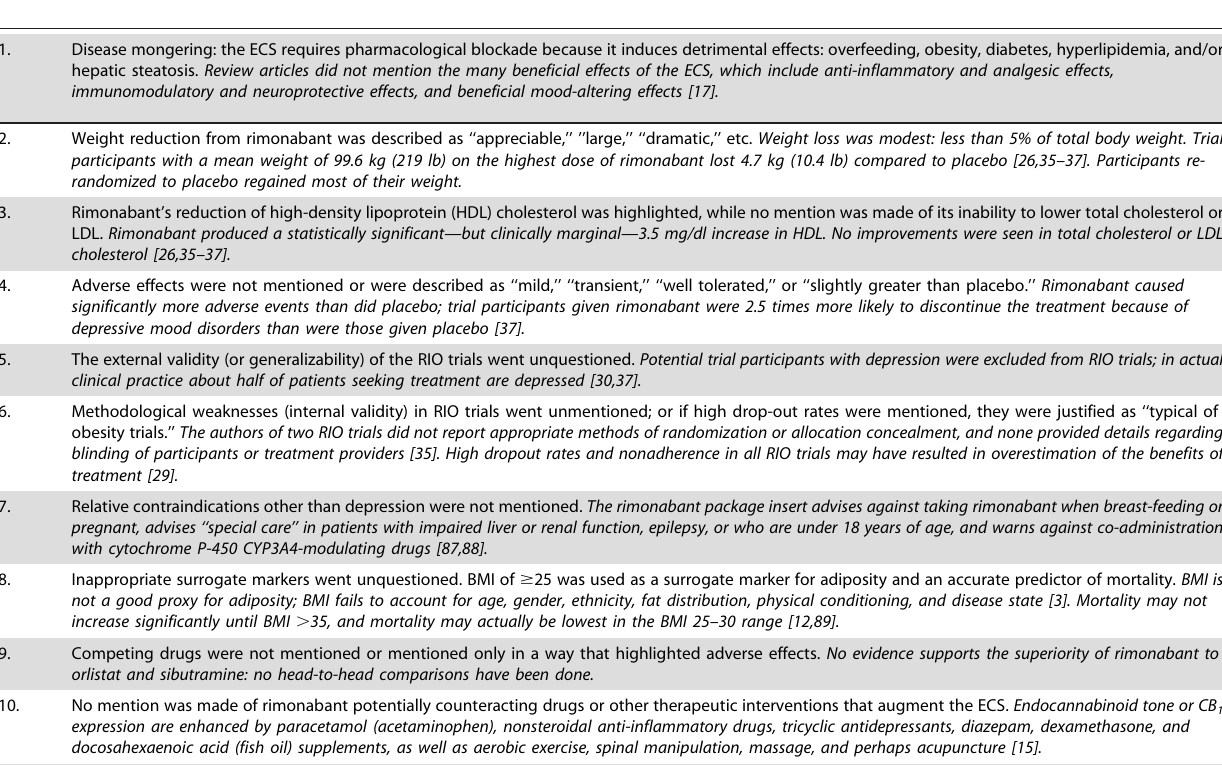
Table 2. Industry-friendly biased statements (or biased omissions) that appeared in at least seven out of eight rimonabant review